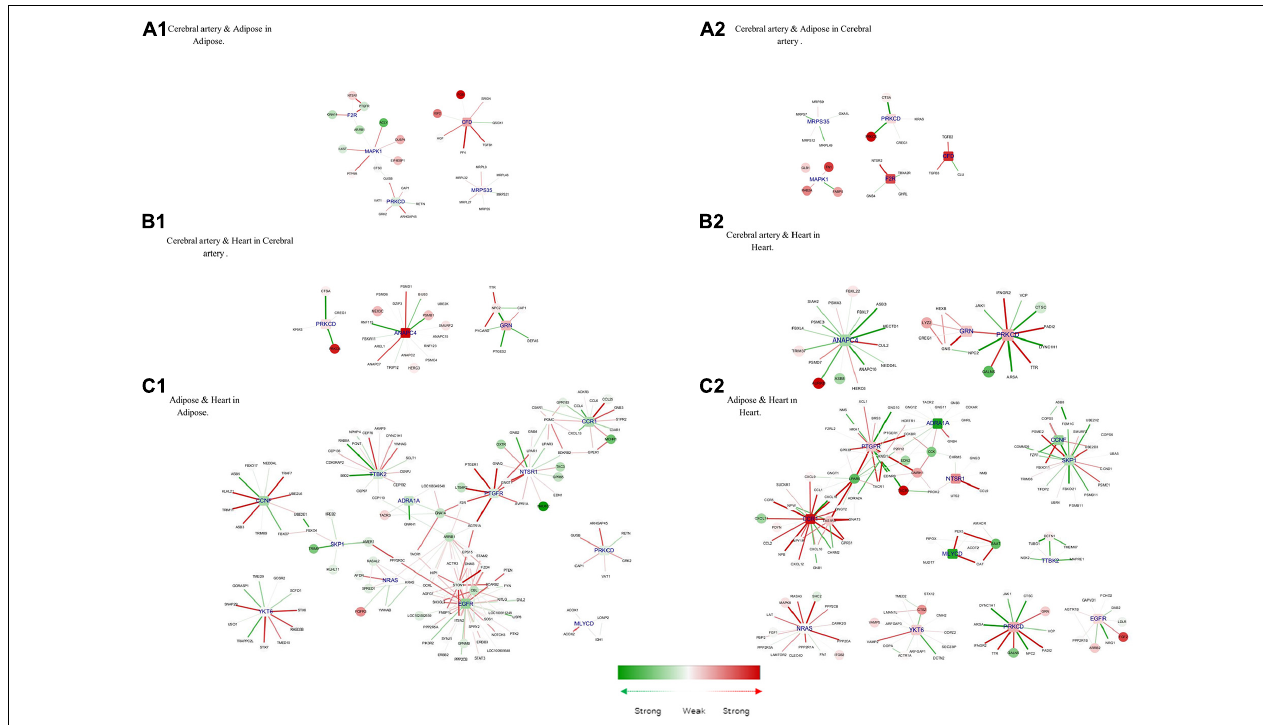
FIGURE 7 | Hub genes of common genes between tissue pair and their corresponding modules. (A1) Cerebral artery and adipose in adipose. (A2) Cerebral artery and adipose in cerebral artery. (B1) Cerebral artery and heart in cerebral artery. (B2) Cerebral artery and heart in heart. (C1) Adipose and heart in adipose. (C2) Adipose and heart in heart. Gene colored in green was differentially expressed between disease and health conditions and was significantly downregulated under disease, while red means upregulated. Edge colored in green means the interaction between its two linked genes was perturbed and was inactivated under disease condition, while red means activated. The width of edges reflect the magnitude of the perturbation. Tissue-specific hub genes were shaped with round rectangle and labeled with